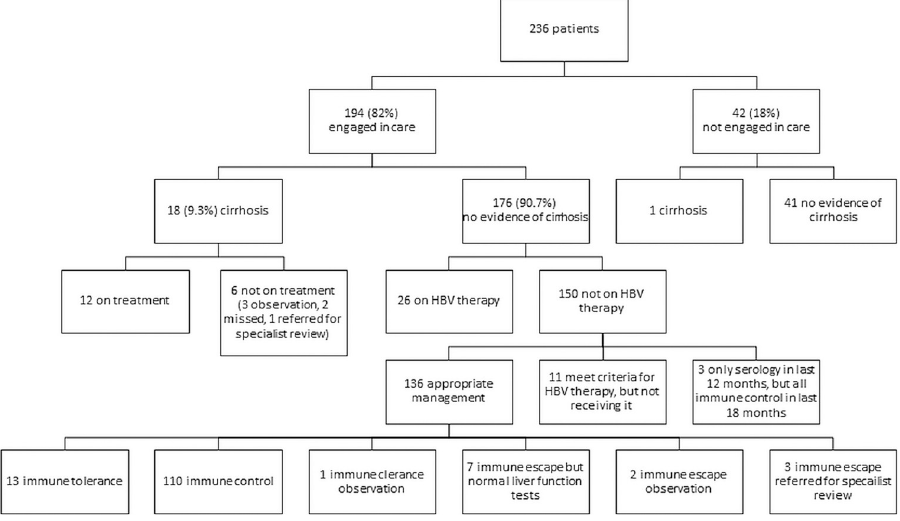
Fig 2. A flow chart demonstrating the proportion of patients living with chronic hepatitis B in the study region who were engaged in care and who were receiving antiviral therapy (stratified by clinical phenotype).